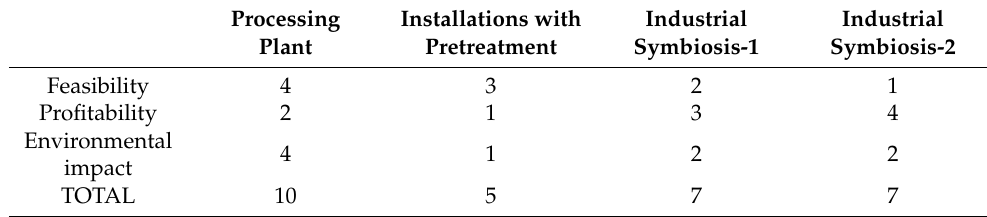
Table 3. Comparison of ranking of business